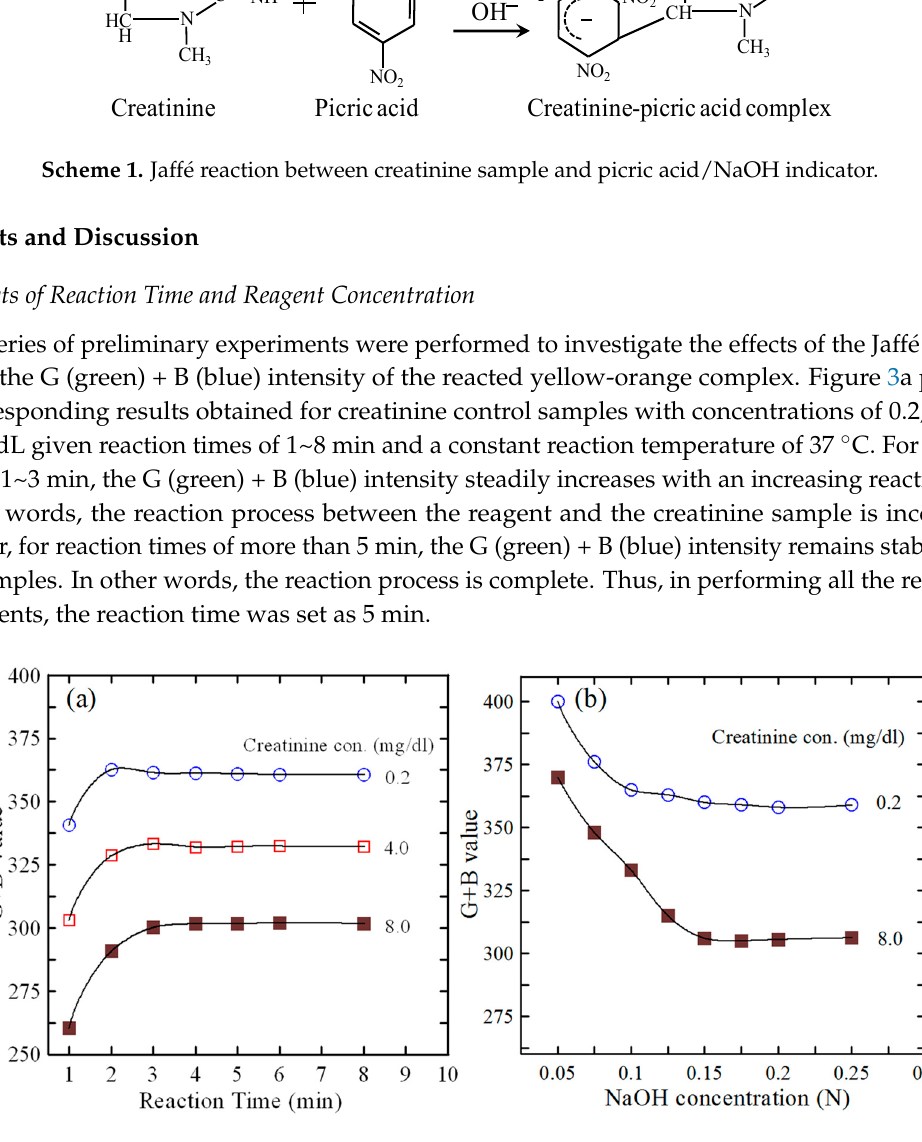
Figure 3. ( a ) Reaction time stability of samples with various creatinine concentrations given reaction temperature of 37 °C; ( b ) G + B values of creatinine samples with concentrations of 0.2 mg/dL and 8 mg/dL given different NaOH concentrations and constant reaction time of 5 min.